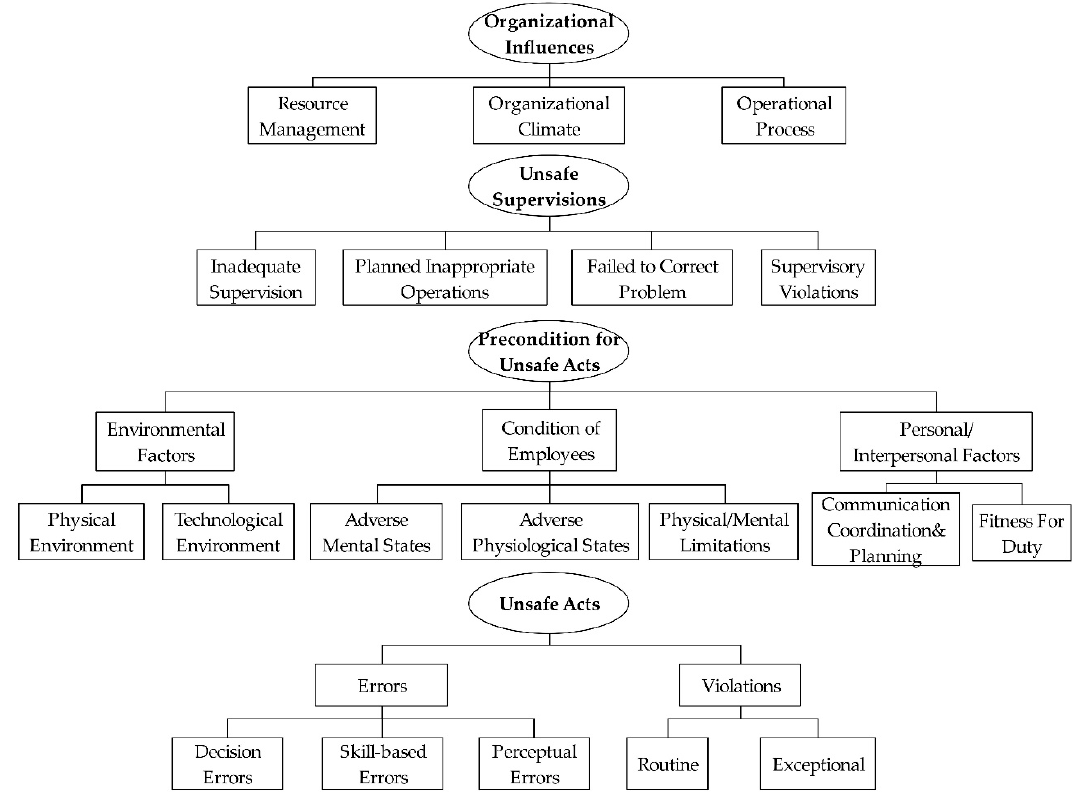
Figure 1. Overview of the human factors analysis and classification system (HFACS).